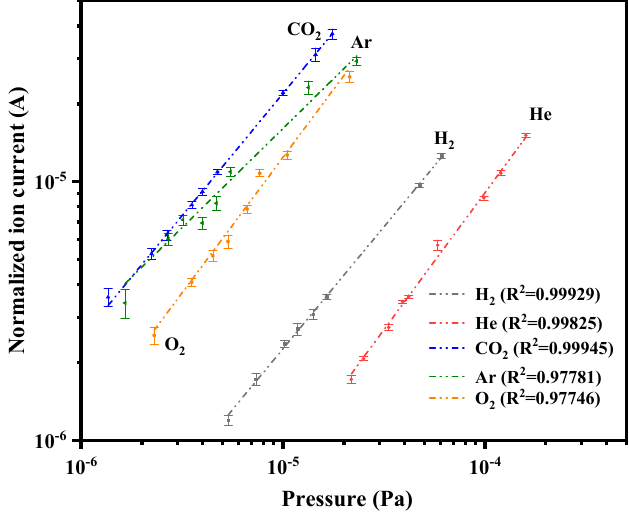
Figure 8. Linearity of the ion production of the CNT-LEIS for different operating gases. Table 1. Calculated sensitivity of the ion current for different gases.